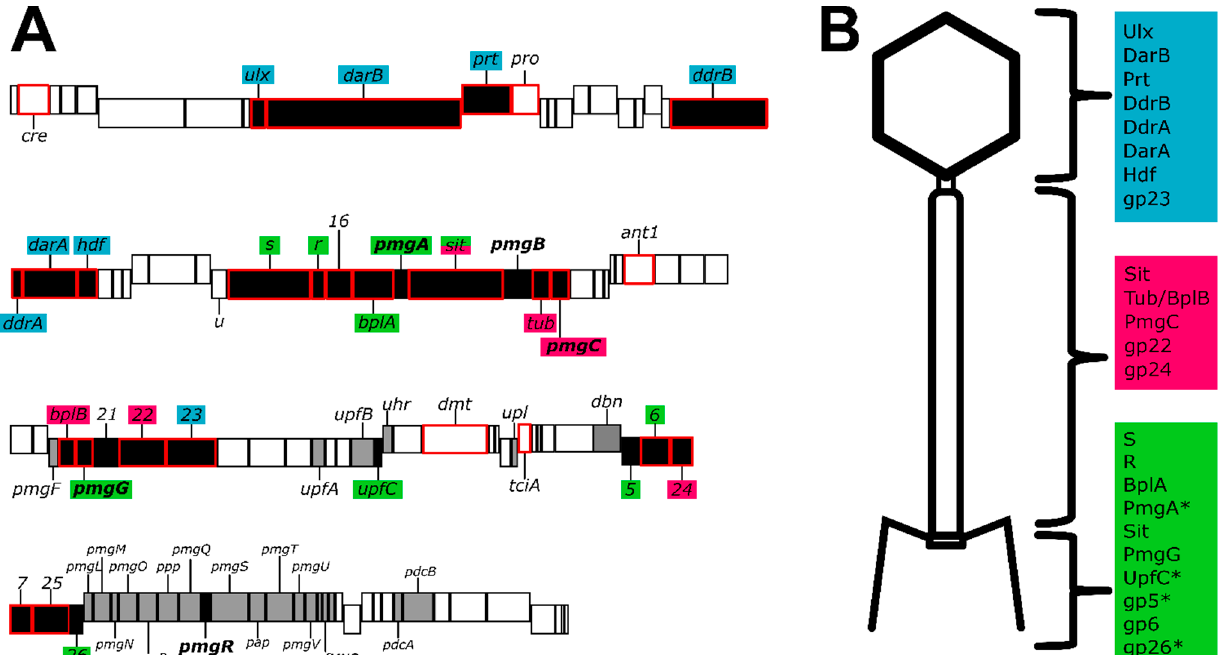
Figure 5. The P1 genome and composition of the virion. A : Genome map of phage P1 summarizing P1 morphogenesis genes. The size of the boxes indicates the size of each ORF, with genes encoded on the plus and minus strands staggered up and down, respectively. Genes colored black are involved in phage morphogenesis, based on the work presented here or in previous studies [10]. Products of genes outlined in red were detected in LC-MS/MS above the two-peptide threshold. Genes with bold labels were determined to be essential for morphogenesis by construction of single-gene deletions. The deletion of gray genes produced no antirestriction phenotype and no apparent defect in plating, thus these genes are considered non-essential with unknown function. Gene labels are color-coded to indicate their predicted location in the virion (panel B), with blue indicating the head, magenta the tail, and green the baseplate. B : A schematic of the P1 virion, partitioned into three components of the head, tail, and baseplate (including tail fibers). Structural proteins are assigned to each area based on their predicted roles; color coding corresponds to the coding of gene labels in panel A. Sit is listed in both the tail and baseplate as its role as tape measure protein makes it a part of both components. Proteins PmgA, UpfC, gp5, and gp26 are marked with an asterisk as these are predicted to be part of the virion based on bioinformatics but were not detected by LC-MS/MS. Gene iddB omitted for simplicity.